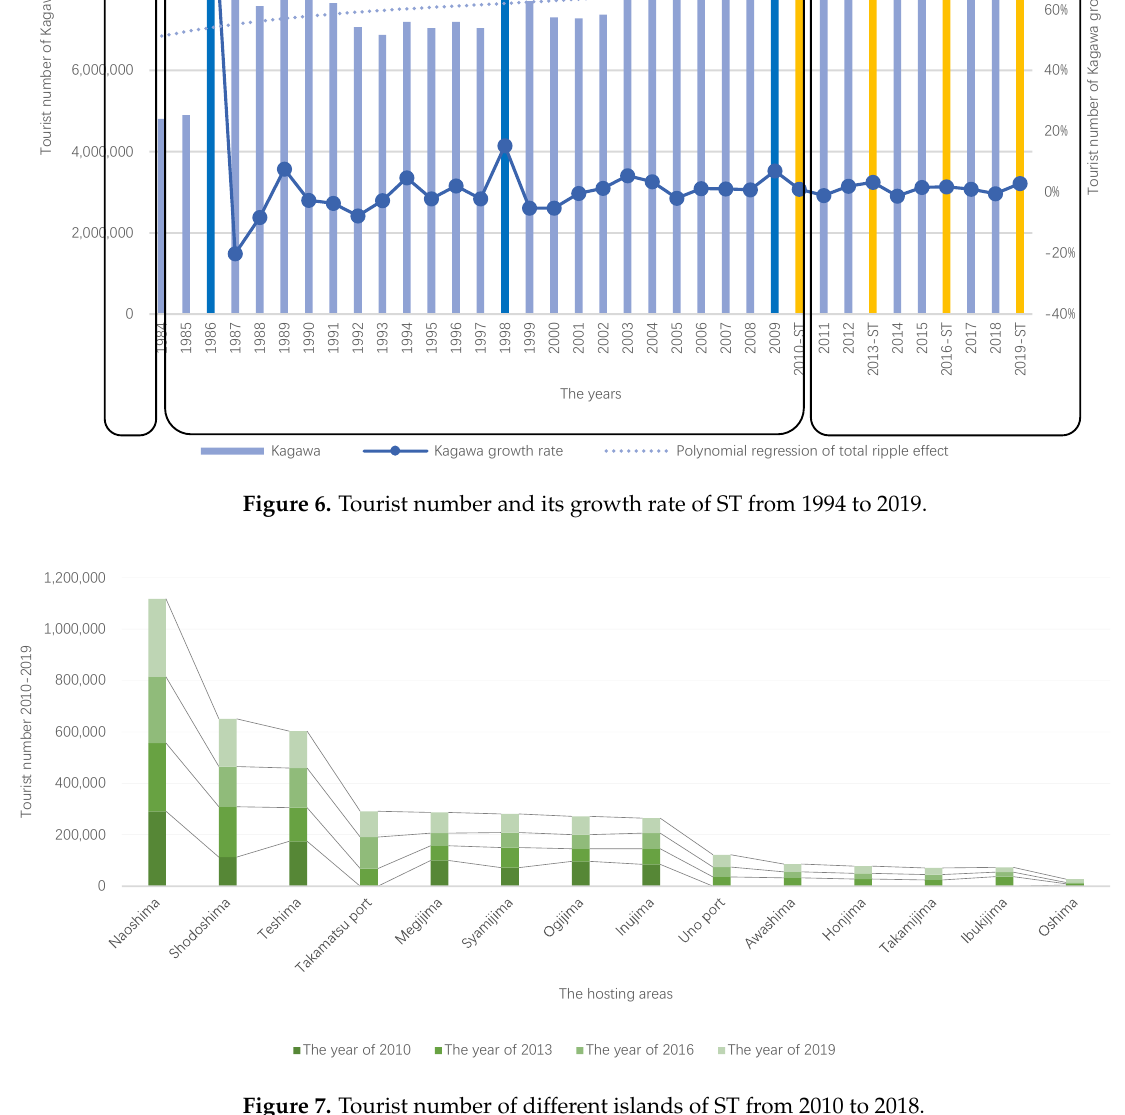
Figure 7. Tourist number of different islands of ST from 2010 to 2018.